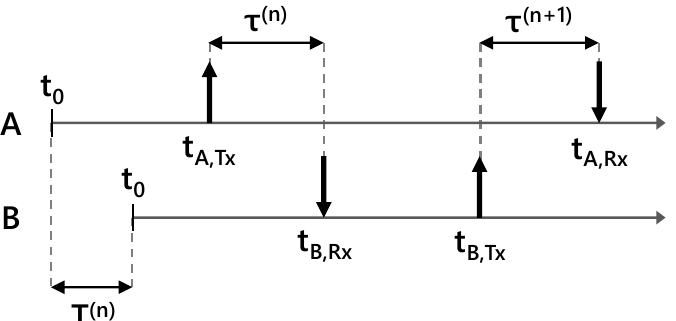
Figure 3. Depiction of two interactions between radios A and B. Interactions are indexed by n . The time offset is labelled T ( · ) and the propagation delay is labelled τ ( · ) . Transmit events are labeled with up arrows, and corresponding receive events are labeled with down arrows. The clocks are ( · ) misaligned, so the receive timestamps t follow (1) and ( · ) , Rx